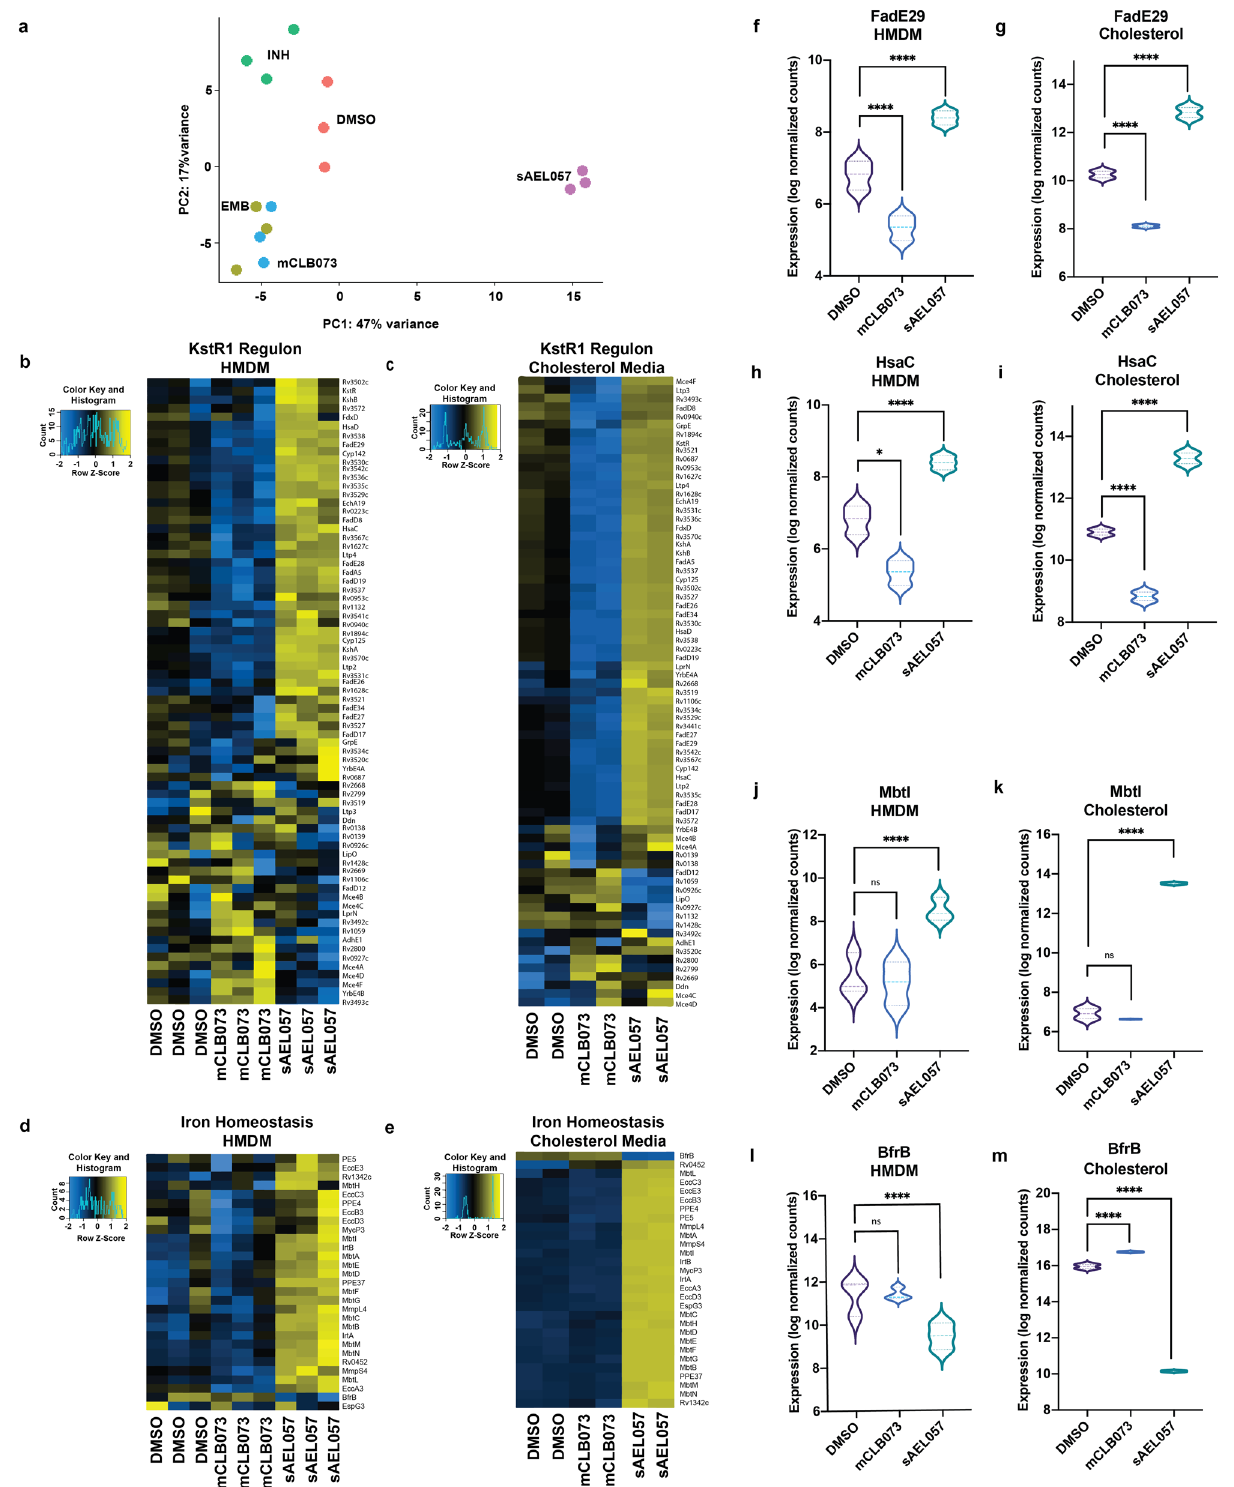
Fig. 2 sAEL057 treatment leads to dysregulation of genes involved in iron homeostasis and cholesterol metabolism in Mtb . a PCA analysis of Mtb transcriptomes from infected HMDMs. b , c Heatmaps showing relative expression of genes in the KstR1 regulon. d , e Heatmaps showing relative expression of genes involved with iron homeostasis. a , b , d , f , h , j , l HMDMs were infected at MOI 2:1 for 2 days with mCherry-expressing Mtb prior to administration of sAEL057 at 10 µ M. Infected macrophages were sorted for mCherry positivity 2 days after sAEL057 treatment was commenced, at 4 dpi. Samples were sorted into triazole prior to RNA extraction. c , d , g , i , k , m Mtb was pre-grown in cholesterol-supplemented media (7H9 + cholesterol) for 2 days prior to the addition of sAEL057 at 10x MIC (23 µ M). Samples were collected at 4 h posttreatment for RNA extraction. Normalized counts were used for the generation of all heatmaps. f – m Violin plots showing expression (in log normalized counts) of genes encoding for HsaC, FadE29, BfrB, and MbtI in the two environmental conditions. Statistical signi fi cance values based on adjusted P values ( p adj ) in Supplementary Data 1 for respective